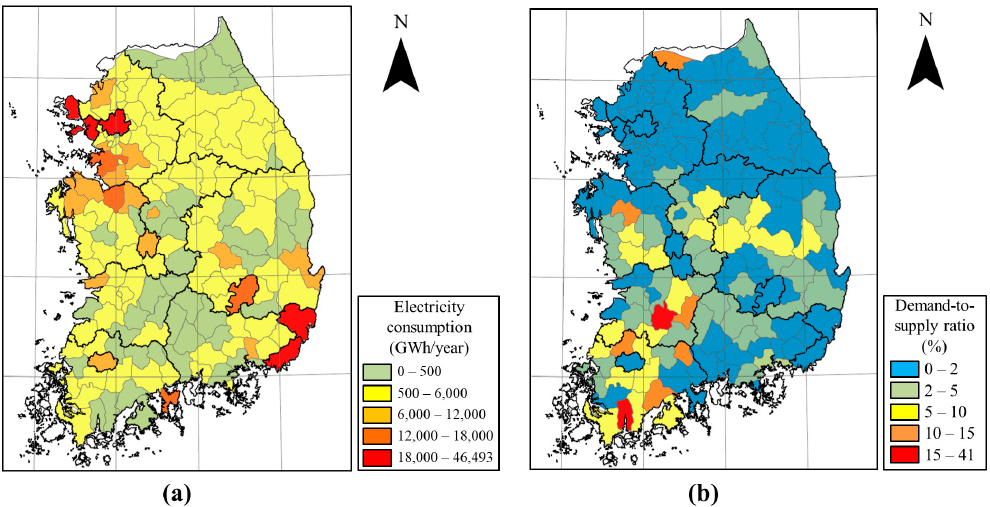
Figure 9. ( a ) Map of the annual electricity usage for the administrative units and ( b ) map of the demand-to-supply ratio for electricity